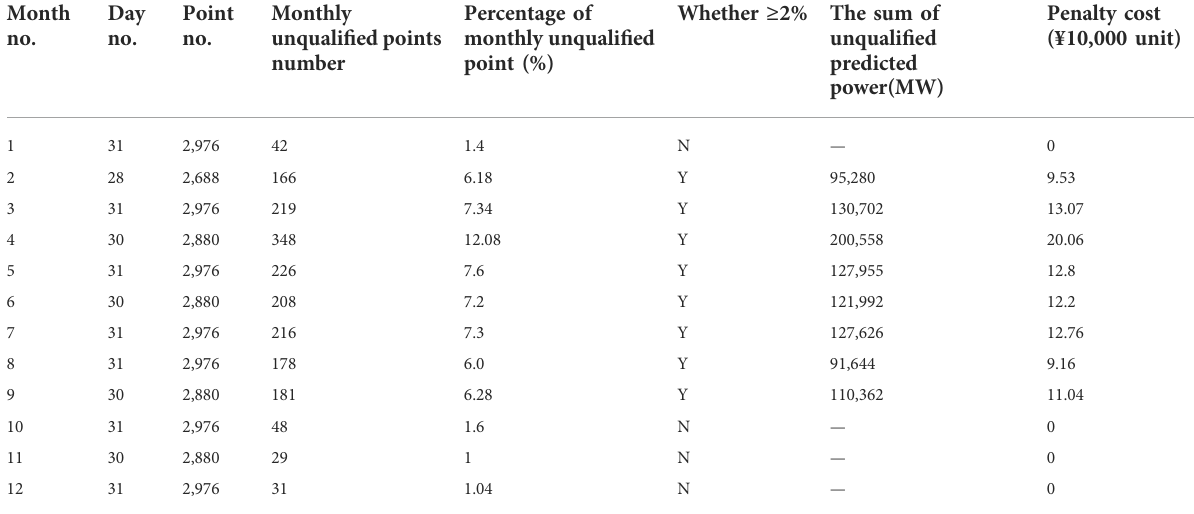
TABLE 3 Statistics and simulation results. Month